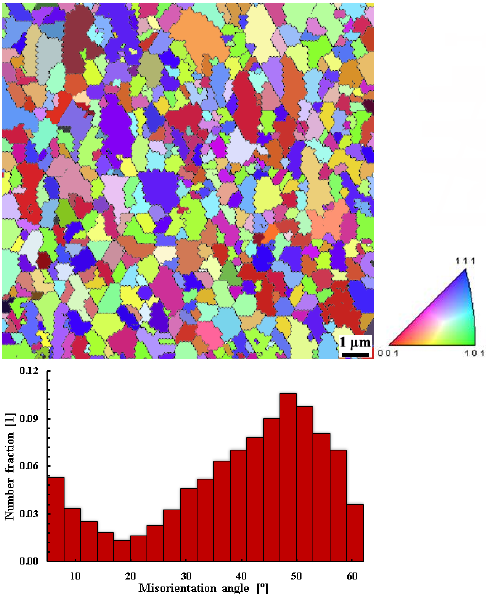
Figure 8. The orientation color map of electron backscatter diffraction for the CP aluminum billet after the four passes of the ECFE